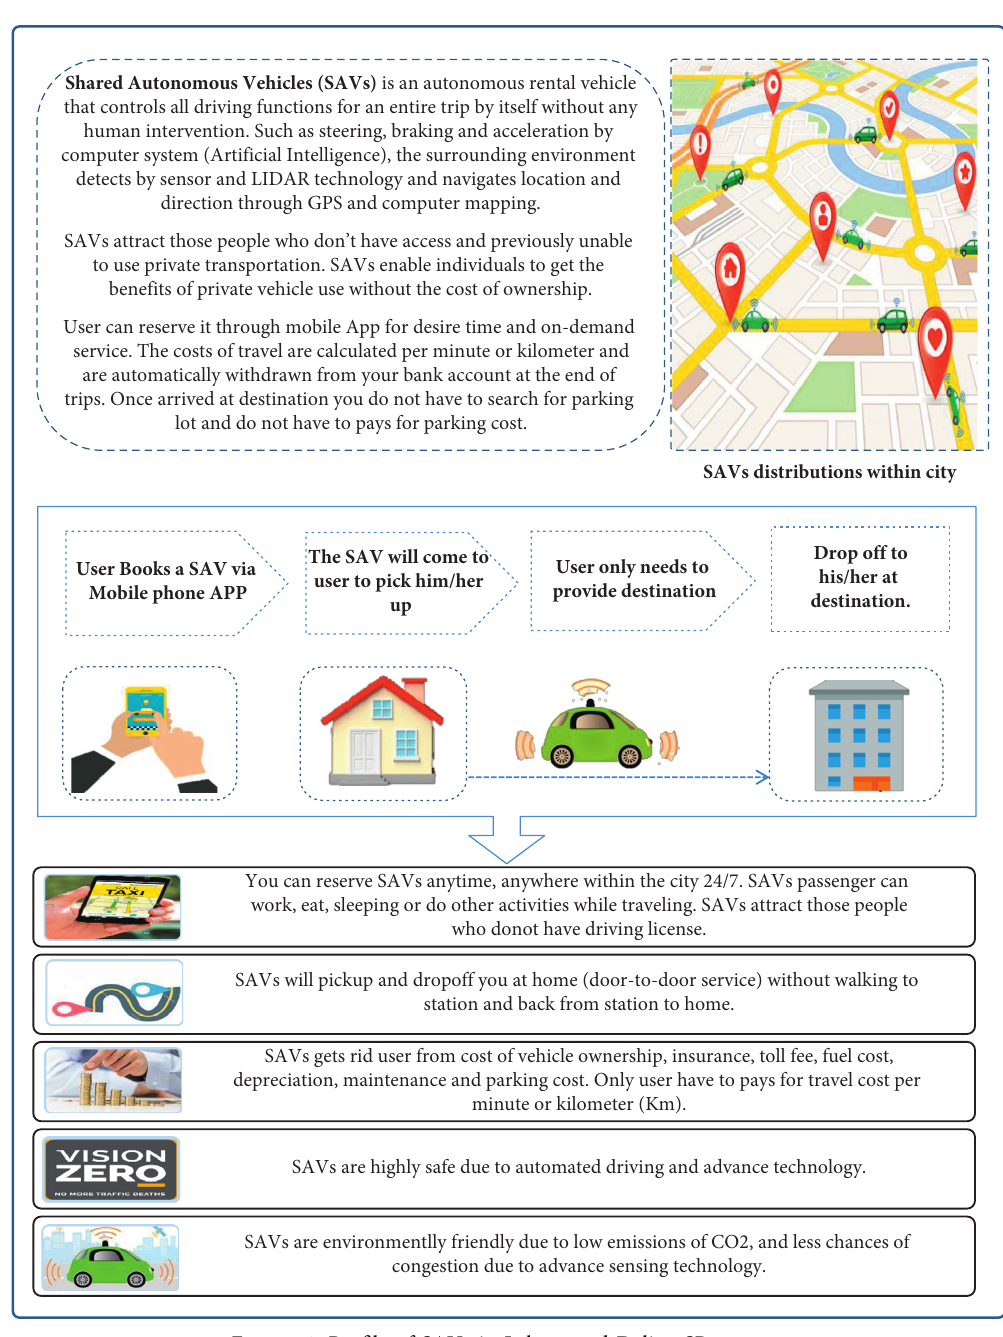
Figure 1: Profile of SAVs in Lahore and Dalian SP surveys. Table 3: Levels of the attributes for each of the alternatives in